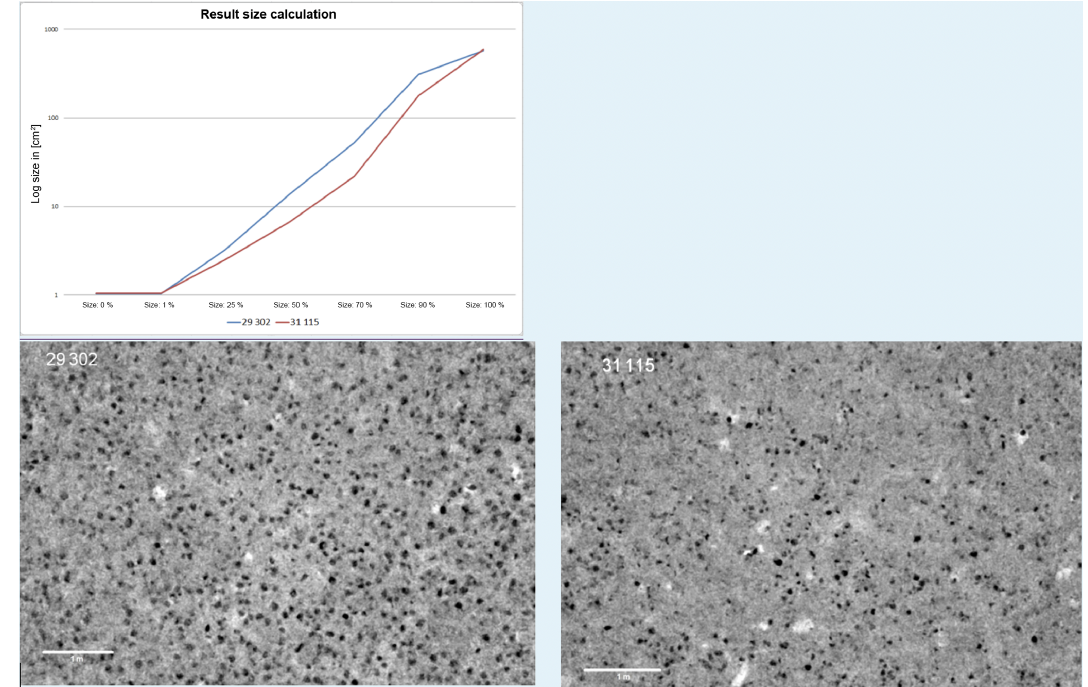
Figure A1. Two example images (bottom) which clearly differ in nodule size and coverage. The graph shows the size distribution as calcu- lated by the CoMoNoD algorithm. The most significant difference is observed in the 75% quantile.